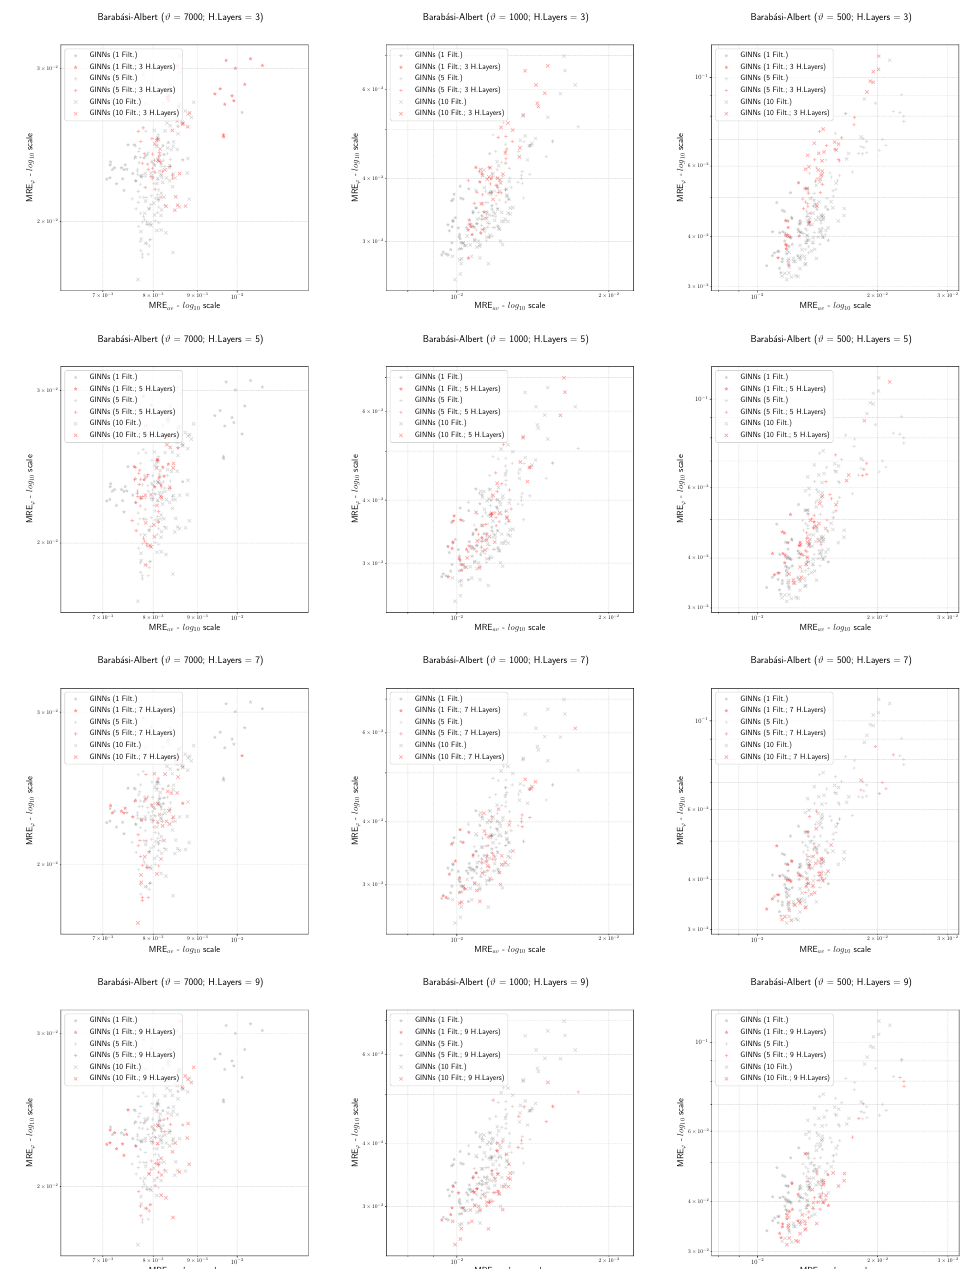
Figure 9. Scatter plots in the ( MRE av ,MRE ϕ ) plane for GINNs trained with respect to right: GINNs trained with ϑ = 7000,1000, 500 samples; top to bottom: red markers highlight GINNs with H = 3,5,7,9 (black markers for all the other